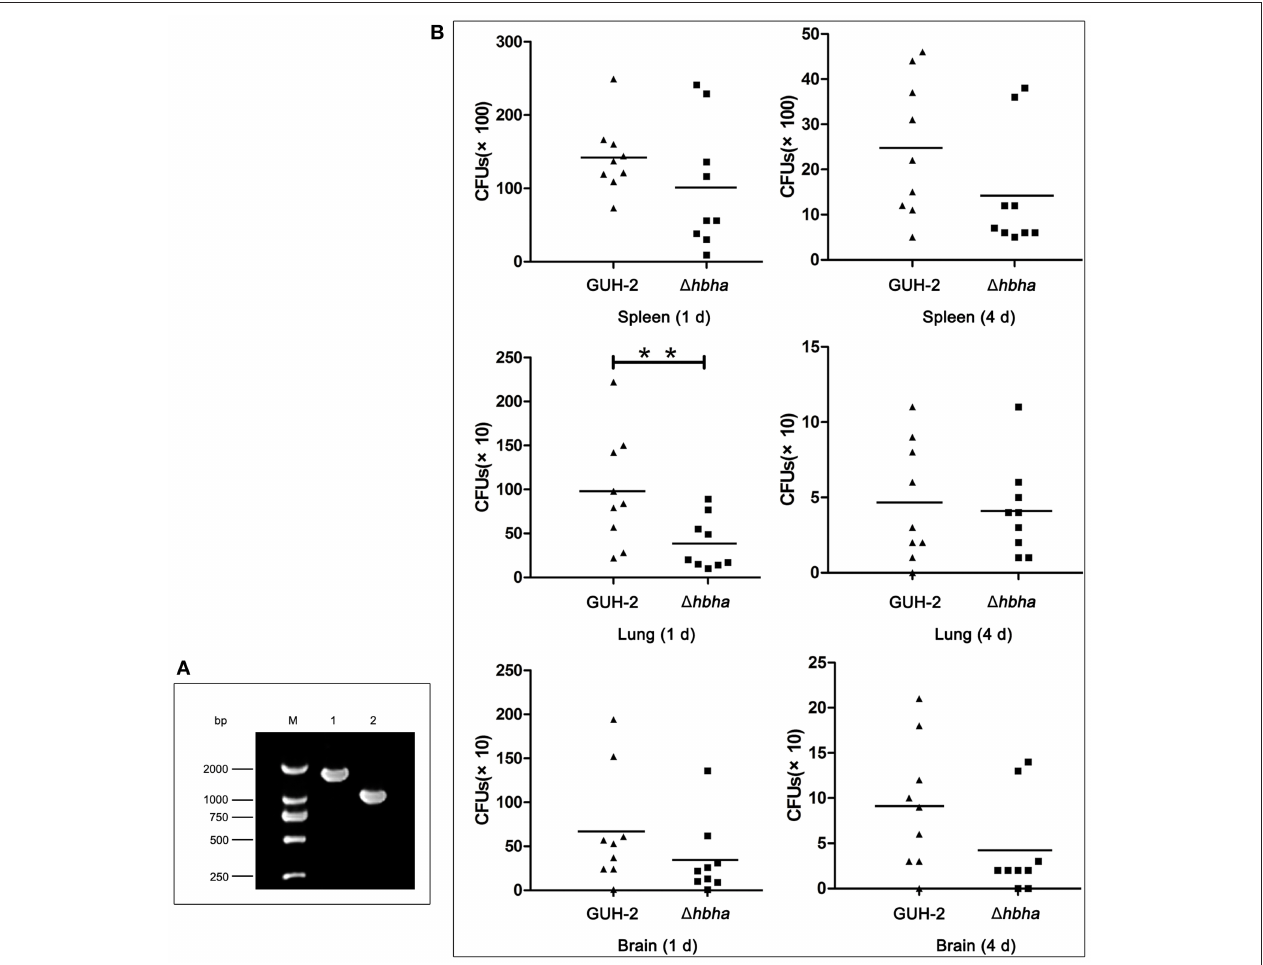
FIGURE 4 | Colonization of N. cyriacigeorgica 1 hbha mutant and wild-type strains in organs of mice. (A) Confirmation of the deletion of the hbha gene by PCR. Lane M: DNA marker. Lane 1: Gene amplification fragments from the genome of wild-type N. cyriacigeorgica . Lane 2: Gene amplification fragments from the genome of the 1 hbha deletion strain. (B) Colonization of wild-type strain and 1 hbha deletion strain in spleens, lungs, and brains of mice at 1 and 4 days after intraperitoneal infection with the N. cyriacigeorgica wild-type or 1 hbha mutant strain. The viable units were counted by plating on brain heart infusion (BHI) plates, and the results of each time point are the means and standard deviations of CFUs from nine mice. ** P <